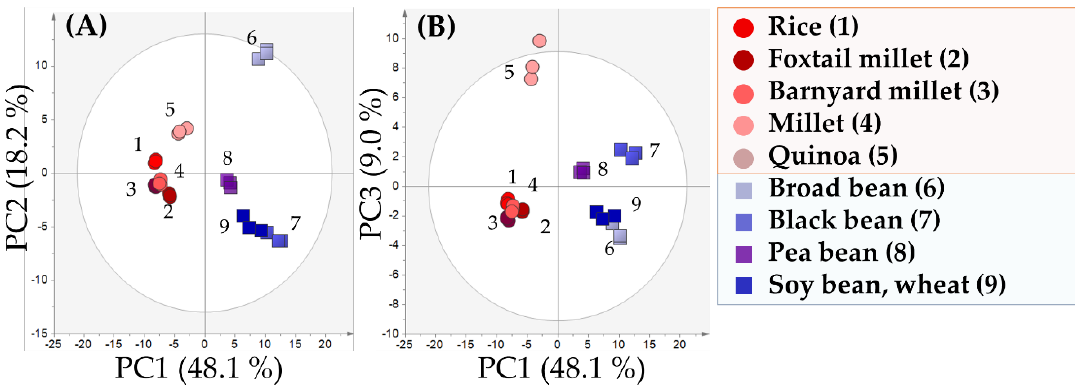
Figure 1. Principal component analysis (PCA) score plot of hydrophilic, low-molecular-weight compounds based on gas chromatography–mass spectrometry (GC / MS). ( A ) PCA score plot (PC1 and PC2). Points and labels indicate samples and sample number, respectively. Circles indicate grain-based samples, and hexagons indicate bean-based samples. ( B ) PCA score plot (PC1 and PC3). Table 1. Characteristic hydrophilic low-molecular-weight compounds in grain-based and bean-based soy-sauce-like seasonings contributing to PC1.